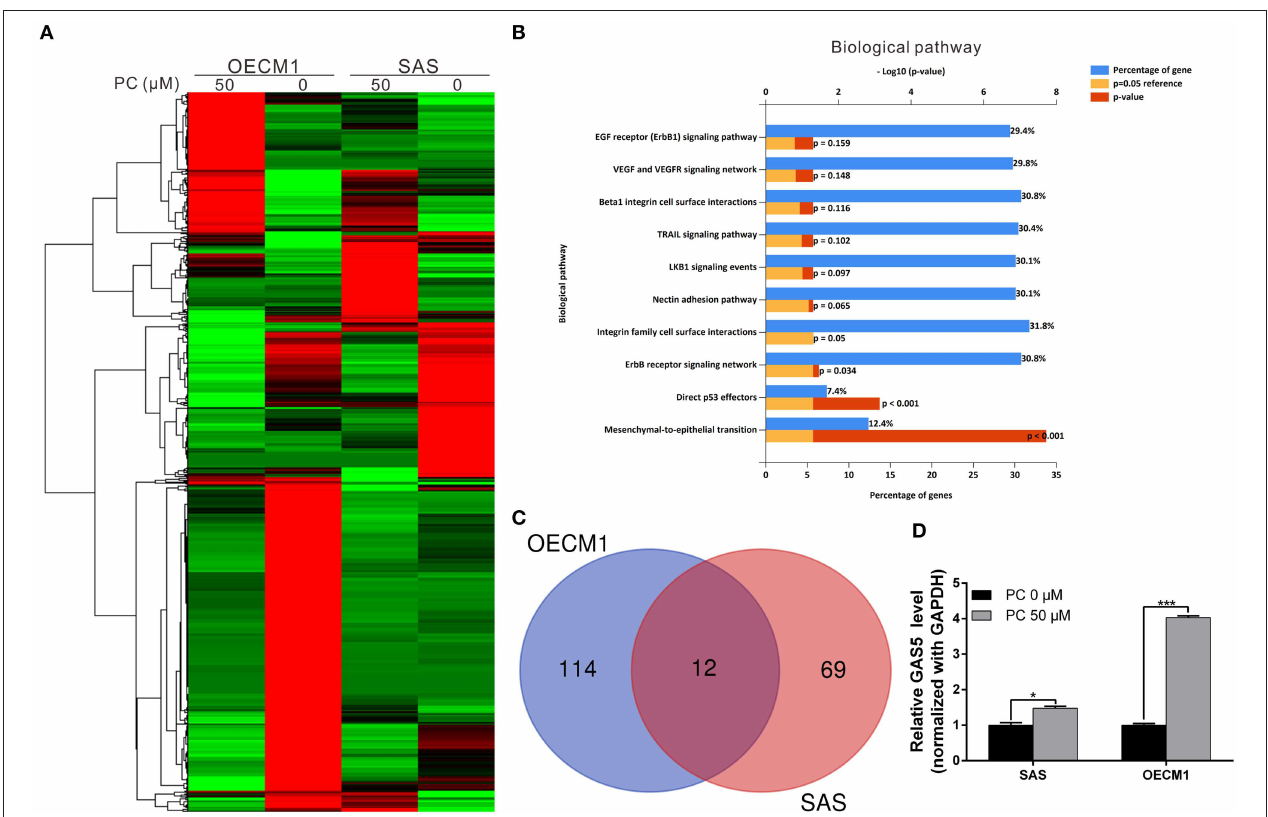
FIGURE 6 | Psorachromene-induced regulation of gene expression related to cell growth and extracellular structure organization. (A) Heatmap comparing significantly different expression of genes in SAS and OECM1 cells treated with or without psorachromene. The bar charts represent the enriched biological pathways (B) associated with the differentially expressed genes after psorachromene treatment. (C) The whole-transcriptome sequencing data shows that 12 lncRNAs manifested higher than a 2-fold change in expression after psorachromene treatment in both cell lines. (D) SAS and OECM1 cells were treated with psorachromene for 48h, and GAS5 expression was analyzed using quantitative real-time RT-PCR. * p < 0.05, *** p <